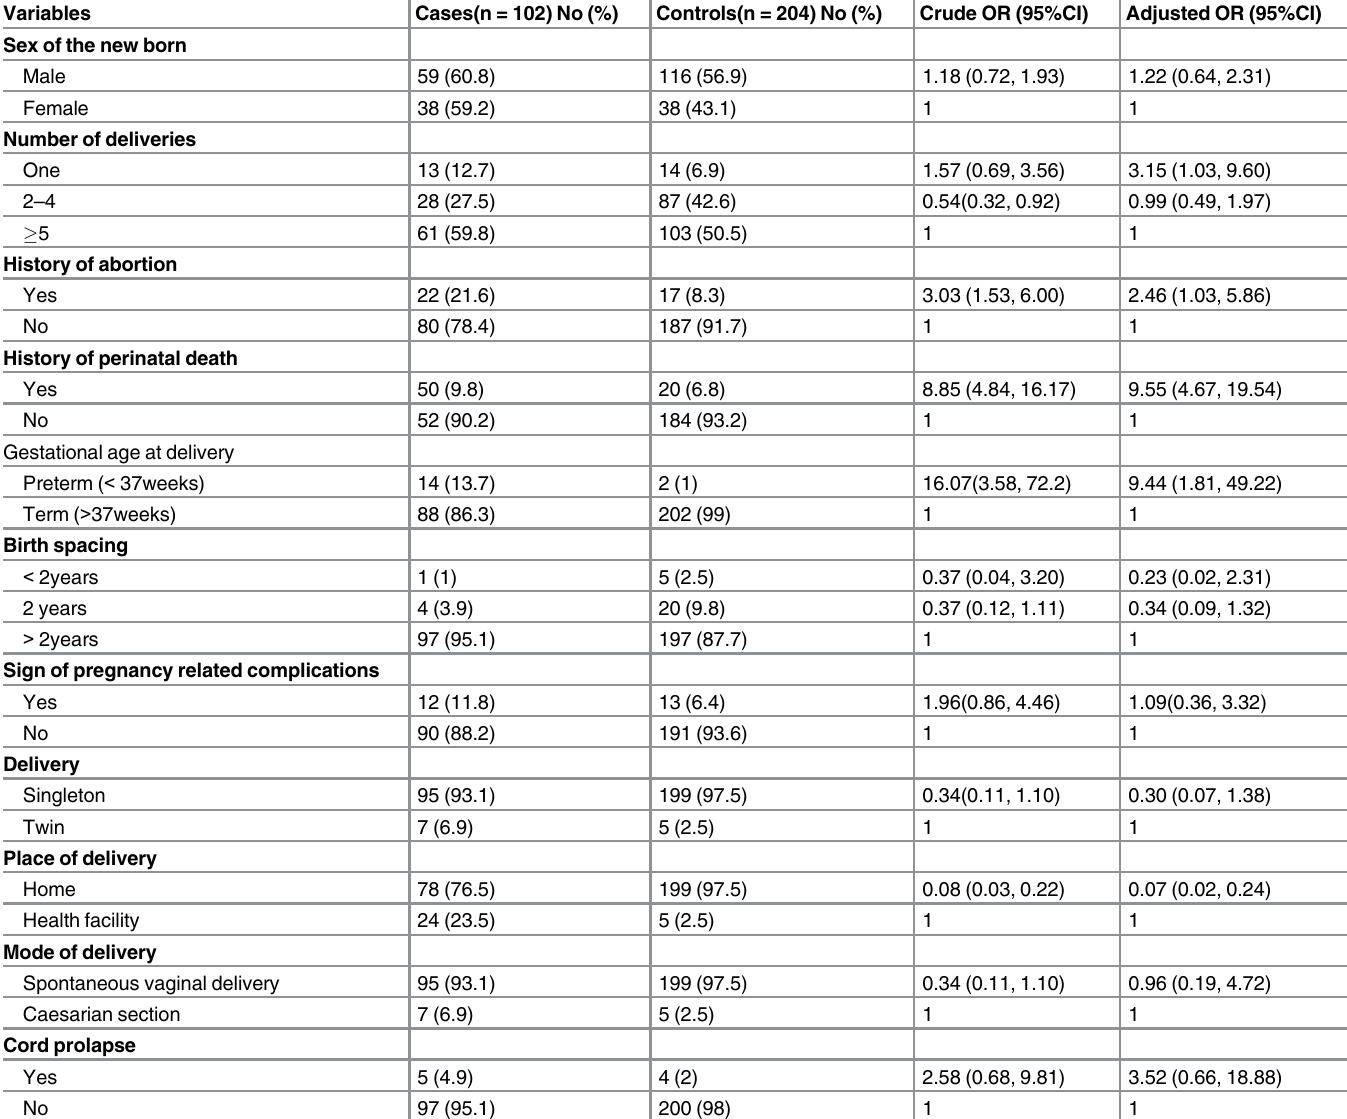
Table 3. Pregnancy, labour and delivery related variables and perinatal mortality in West Gojam zone, Ethiopia Feb 2012(n =